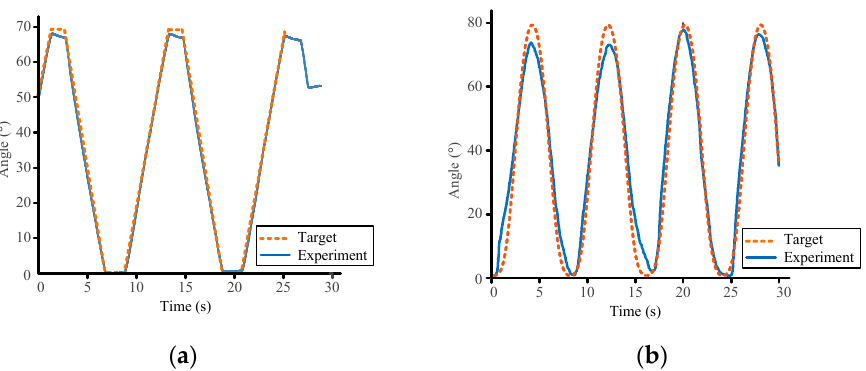
Figure 13. The comparison diagram of the experimental values and the target values for ( a ) MCP joints and ( b ) PIP joints.